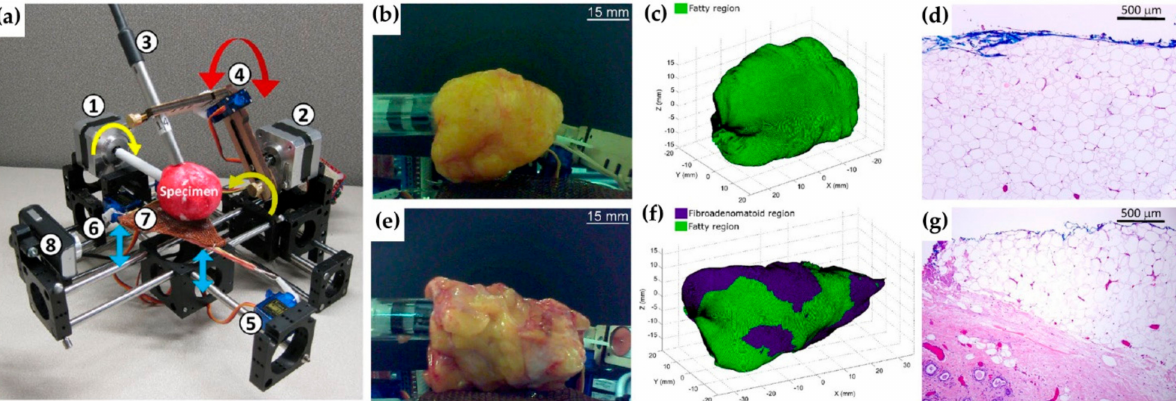
Figure 6. ( a ) Photograph of the automated 3D margin scanner prototype (Marginbot), developed by Thomas et al.: 1 (cid:13) motor A rotates the specimen in the horizontal axis, while 2 (cid:13) motor B moves the 3 (cid:13) optical probe along the specimen’s surface; 4 (cid:13) servomotor A enables the contact mode and non-contact mode of the optical probe 1 (cid:13) with the specimen placed on the 7 (cid:13) specimen holder; 5 (cid:13) , 6 (cid:13) servomotor B moves the specimen holder 7 (cid:13) upwards, pushing the specimen towards the probe during the contact mode and downwards in the non-contact mode. The ( 8 (cid:13) ) compact camera enables image reconstruction of the specimen. ( b – g ) Automated 3D margin assessment of human breast specimens. ( b ) Photograph of the breast specimen with fatty margins; ( c ) margins of the specimen rendered by the scanner; ( d ) 10 × magnification of an H&E human breast section; ( e – g ) corresponding figures for a breast specimen with fibroadenomatoid margins (color code for margin classification in ( c ) and ( f ): green—>50% fat composition, blue—>50% fibroepithelial/fibro-glandular composition)